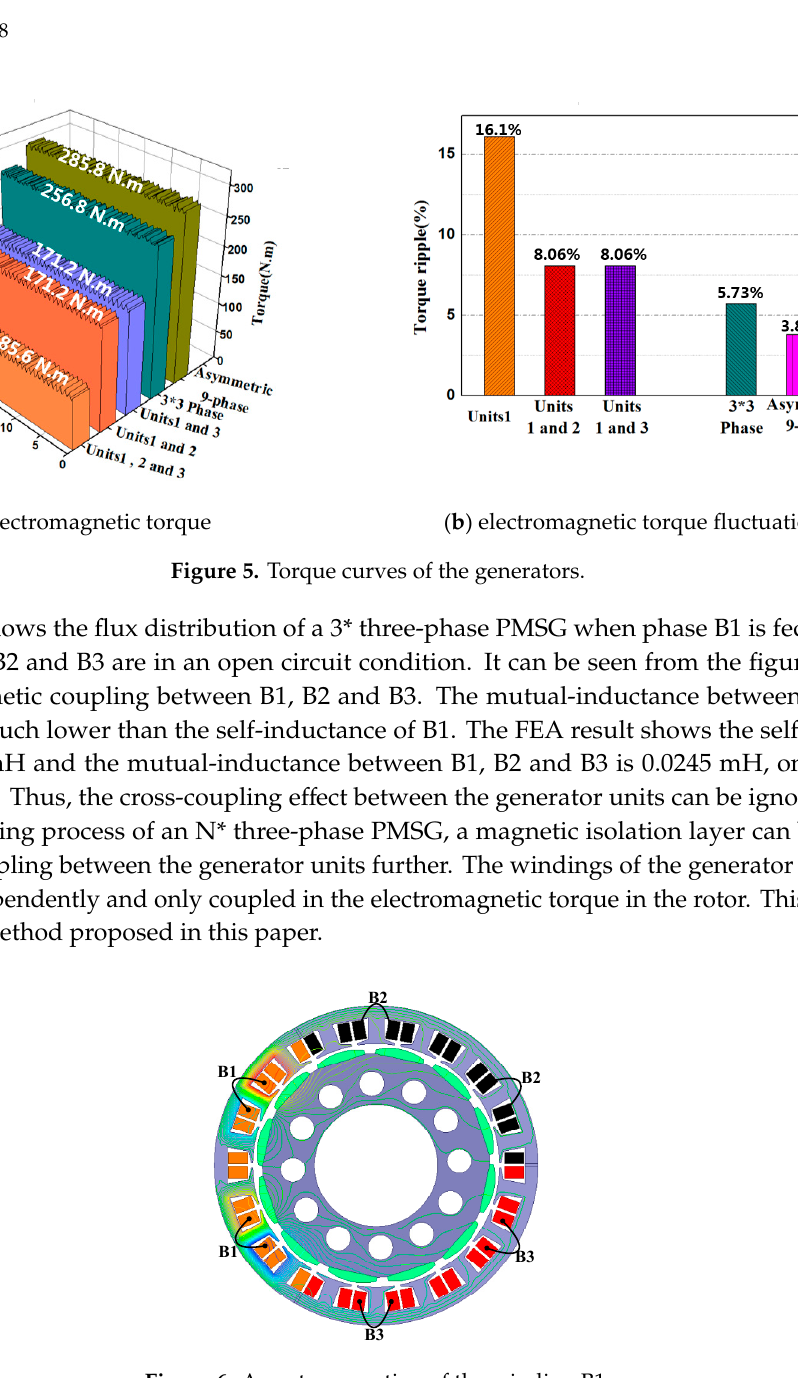
Figure 7. Magnetic cloud and line map of 3* three-phase PMSG. 3. Mathematical Model of N* Three-Phase PMSG Considering the analysis of the electromagnetic characteristics of the N* three-phase PMSG, it can be seen that the N* three-phase PMSG consists of n sets of three-phase PMSG units and the inter- action between each unit is minimal, which could be neglected. According to reference [20], the math- ematical model of the N*three-phase PMSG in the d-q coordinate system could be equivalent to that of a traditional three-phase PMSG. Thus, the d-q axes voltage transformation of one three-phase winding can be written as: